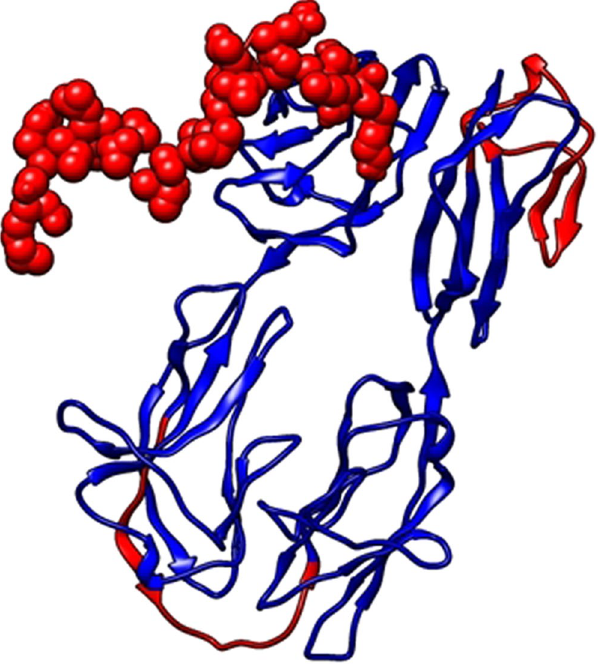
Figure 1. B- cell epitope prediction, discontinuous B- cell epitope have been represented as red spheres in carrier protein and linear epitopes are represented as red lines.